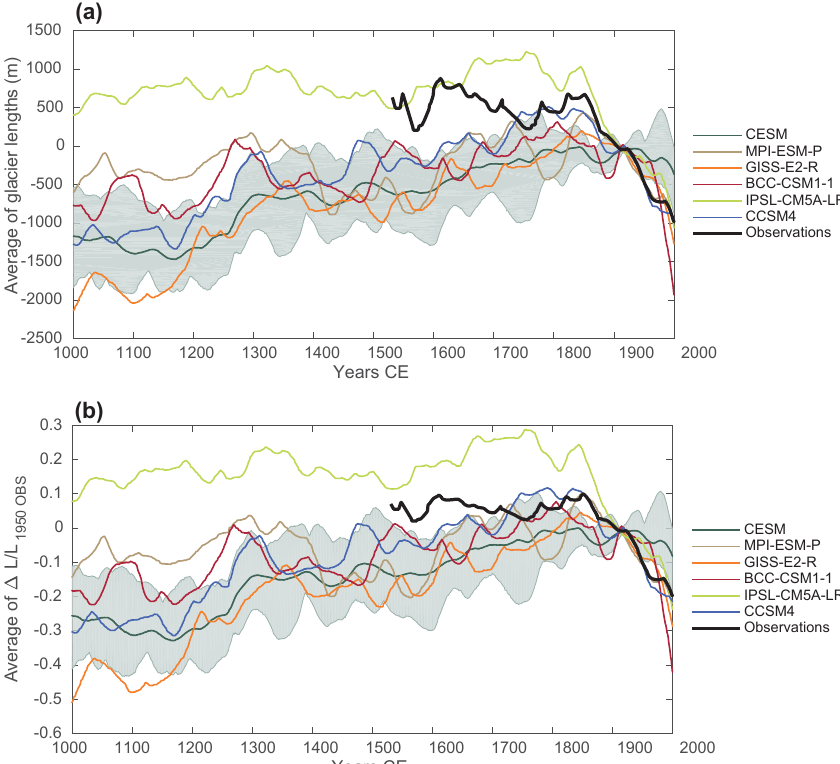
Figure 3. (a) Absolute and (b) relative length changes averaged over the 71 glaciers. The relative length is obtained by dividing the glacier changes by their length in 1950 in the compilation of Leclercq et al. (2014). The average for observations is calculated over the available time series for each period, meaning that the number strongly decreases with time and, in particular, is very low before 1700. The reference period is